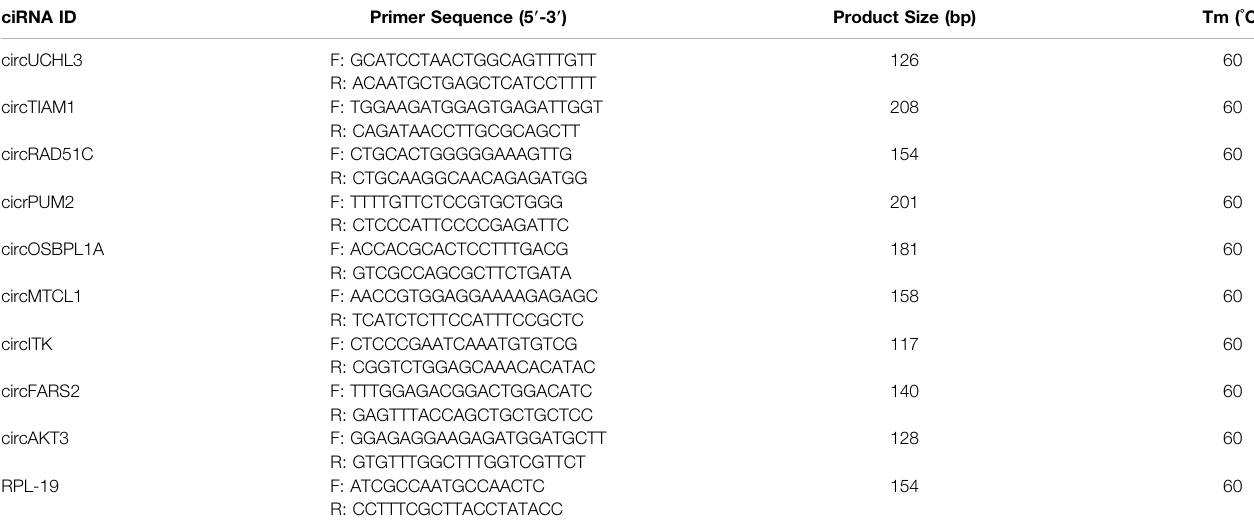
TABLE 1 | The primer information of DE circRNAs.